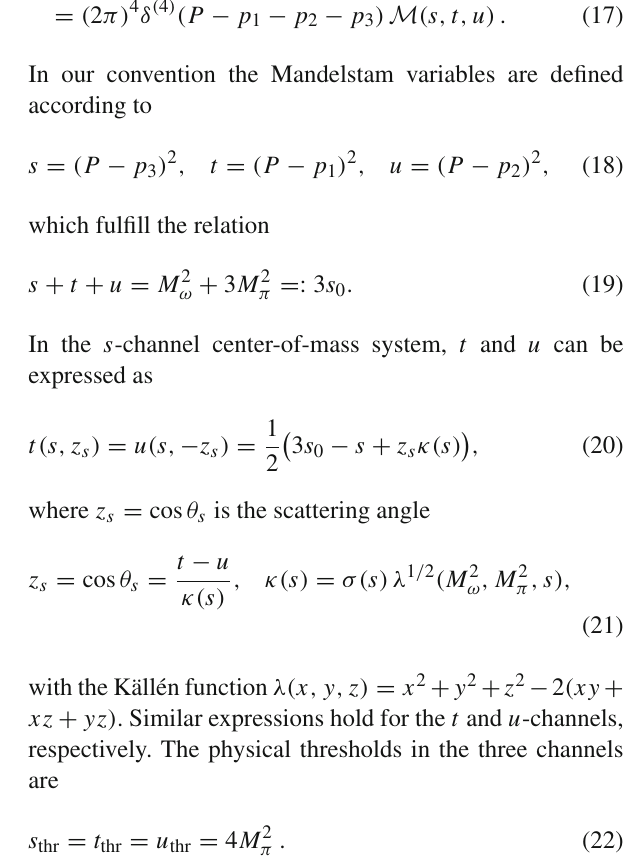
Fig. 2 IAM amplitude ππ P -wave scattering phase shift for different values of the pion mass: 0 (blue), 1 low), 2 ¯ M π (orange), and 5 uncertainty of F and ¯ l . The color coding is identical to Fig.